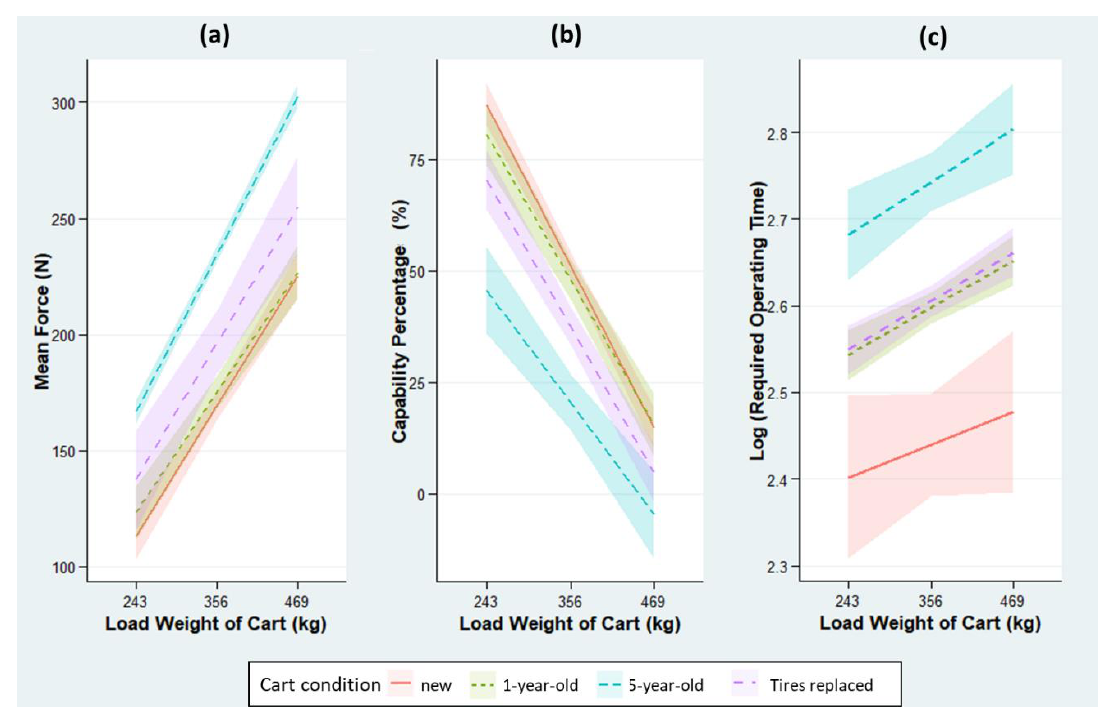
Figure 4. Estimated values: ( a ) ROF, ( b ) CP, and ( c ) ROT for carts of different conditions by fitting the actual measurements in Experiment 1a from the final linear regression models. The ribbons indicate 95% confidence intervals.